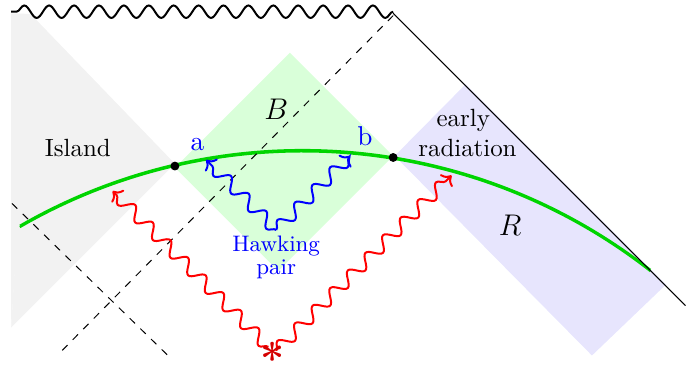
Figure 8. A late time slice through an evaporating black hole space-time. The blue region represents the early Hawking radiation R and the green region is described by some dual strongly coupled CFT, labeled B . For a black hole past its Page time, B is maximally entangled with R . Modes inside the gray ‘Island region’ have in their past collided with outgoing modes inside R . A late Hawking pair a and b is contained inside the entanglement wedge of CFT. The interior mode a is decoupled from the early radiation R ; its reconstruction via CFT operators involves a projection on a code subspace with given soft